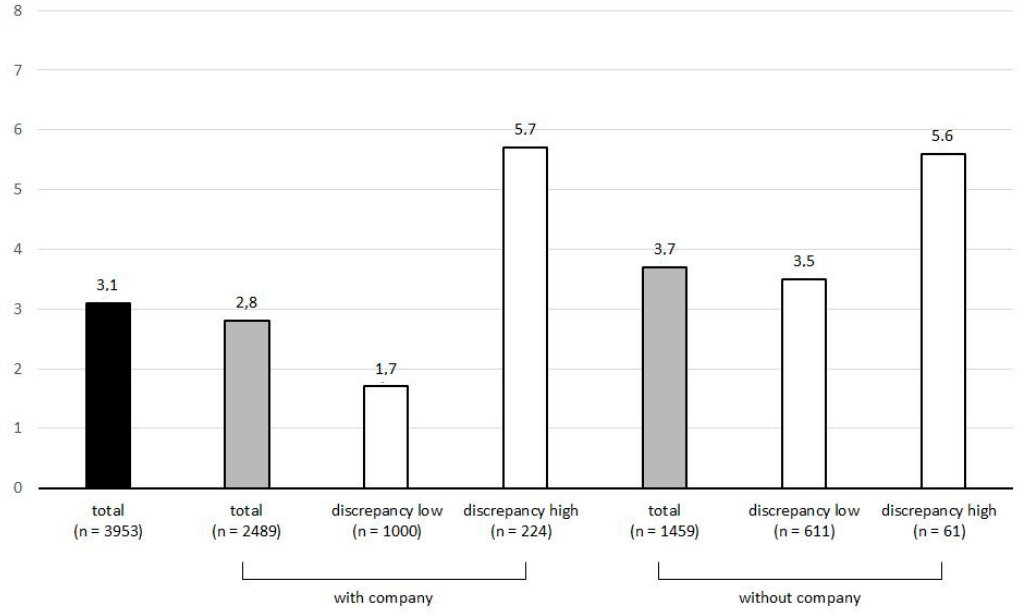
Figure 1. Mean values of thwarted belongingness for different conditions of company. Grey bars represent the variable ‘Presence of company’, and white bars represent the variable ‘Desirability of company’. Subsequent multilevel analysis tested whether the described differences were statistically significant.